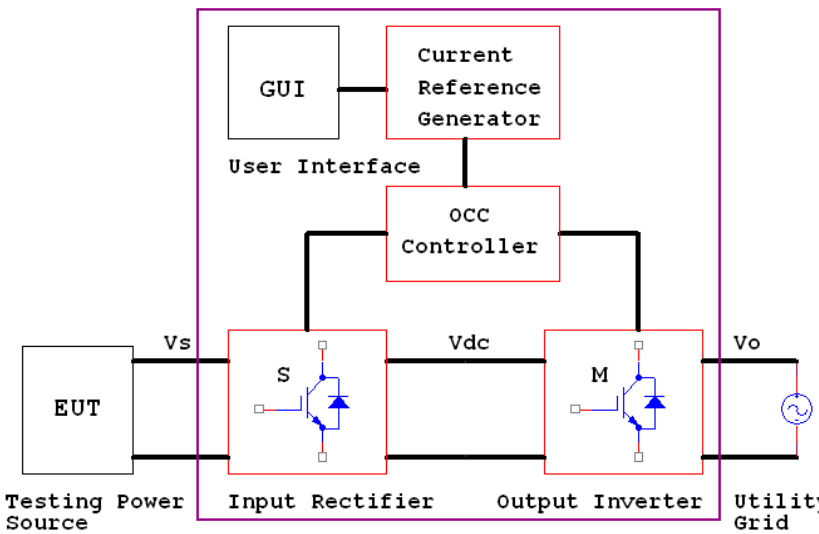
Figure 1. Multilevel OCC MV Regen-Load implementation.